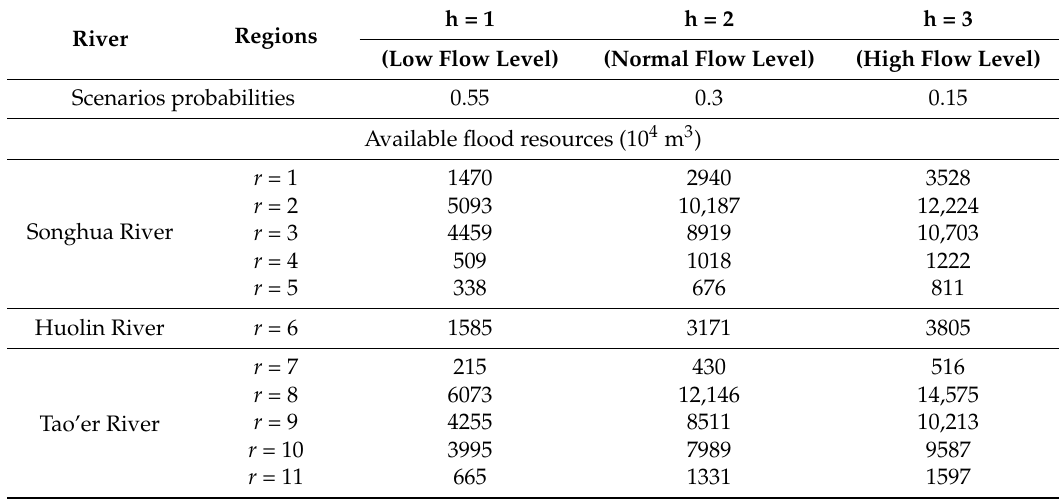
Table 1. Scenario probabilities and regional available flood resources in western Jilin Province.